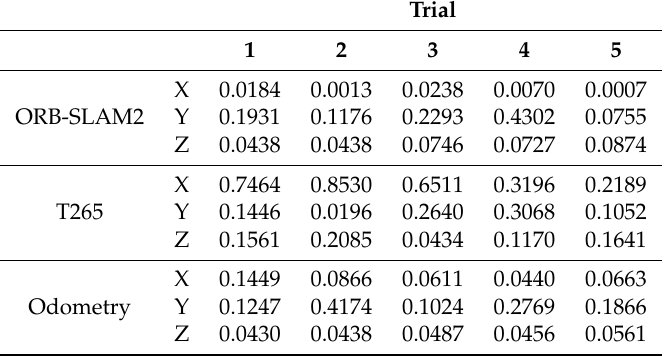
Table 7. Results for the indoor scenario 2 test 1: Walking straight. Error units (m).